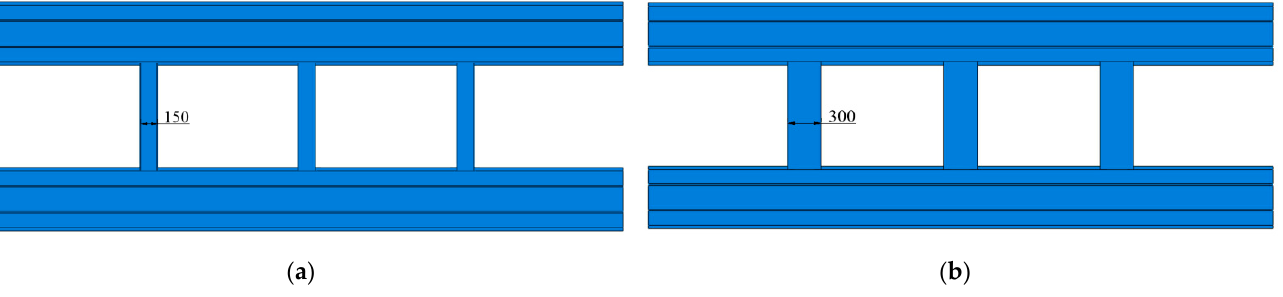
Figure 5. Schematic diagram of different beam width structure. ( a ) Beam width 150 mm and ( b ) beam width 300 mm.